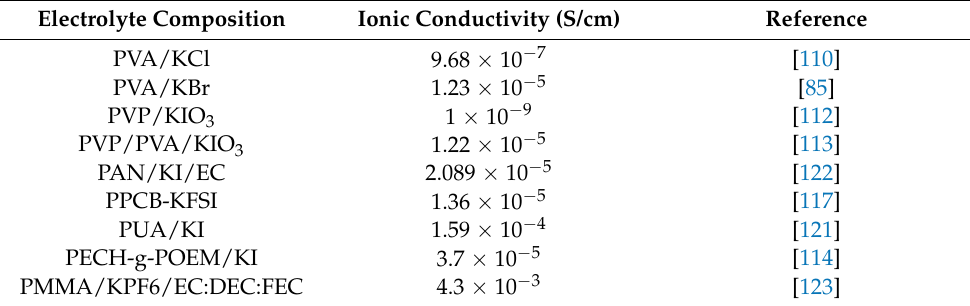
Table 3. Performance parameters of non-PEO-based PEs for